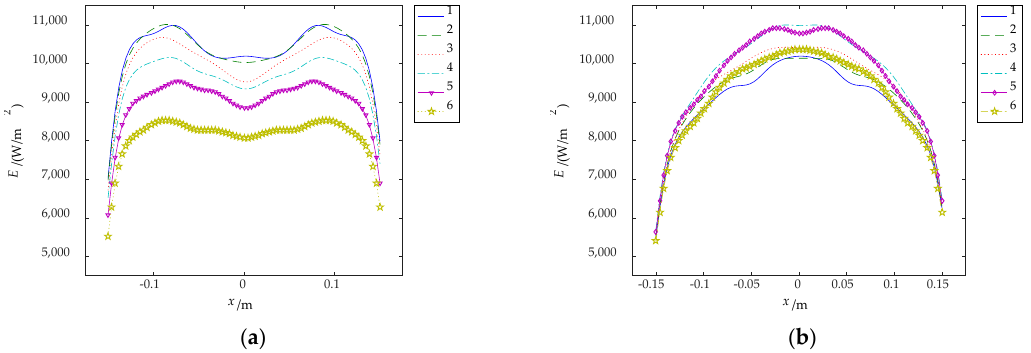
Figure 9. Irradiance distribution of sample line. ( a ) Transverse sampling line; ( b ) longitudinal sampling line.